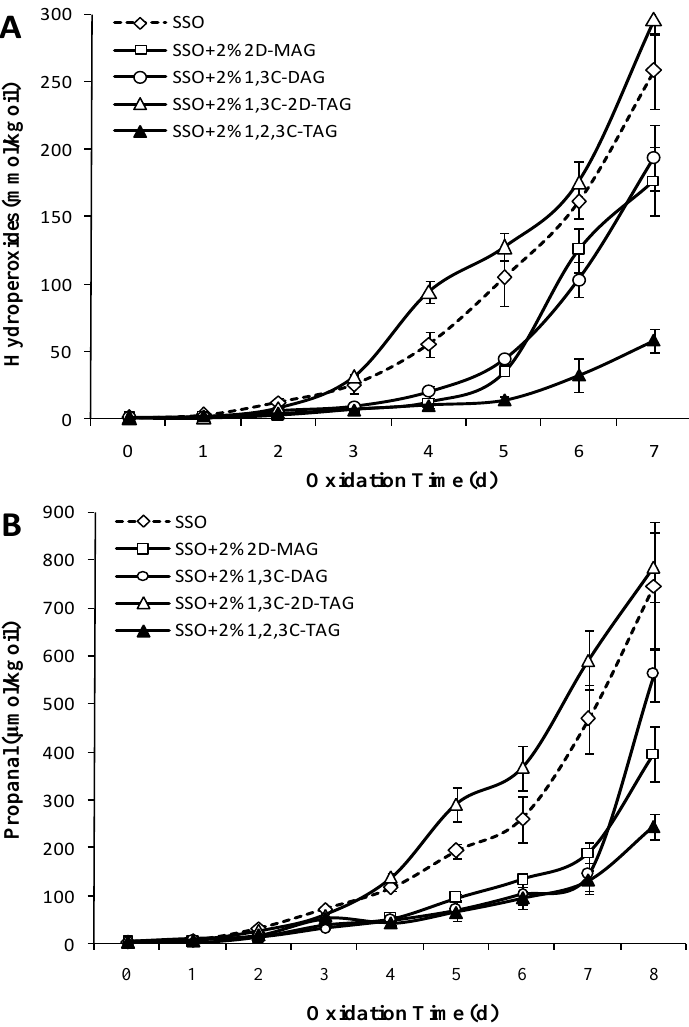
Figure 2. Effect of different structured lipids on the content of refined oil peroxide value (POV) ( A ) and propanal ( B ) in stripped soybean oil (SSO) (50 °C).